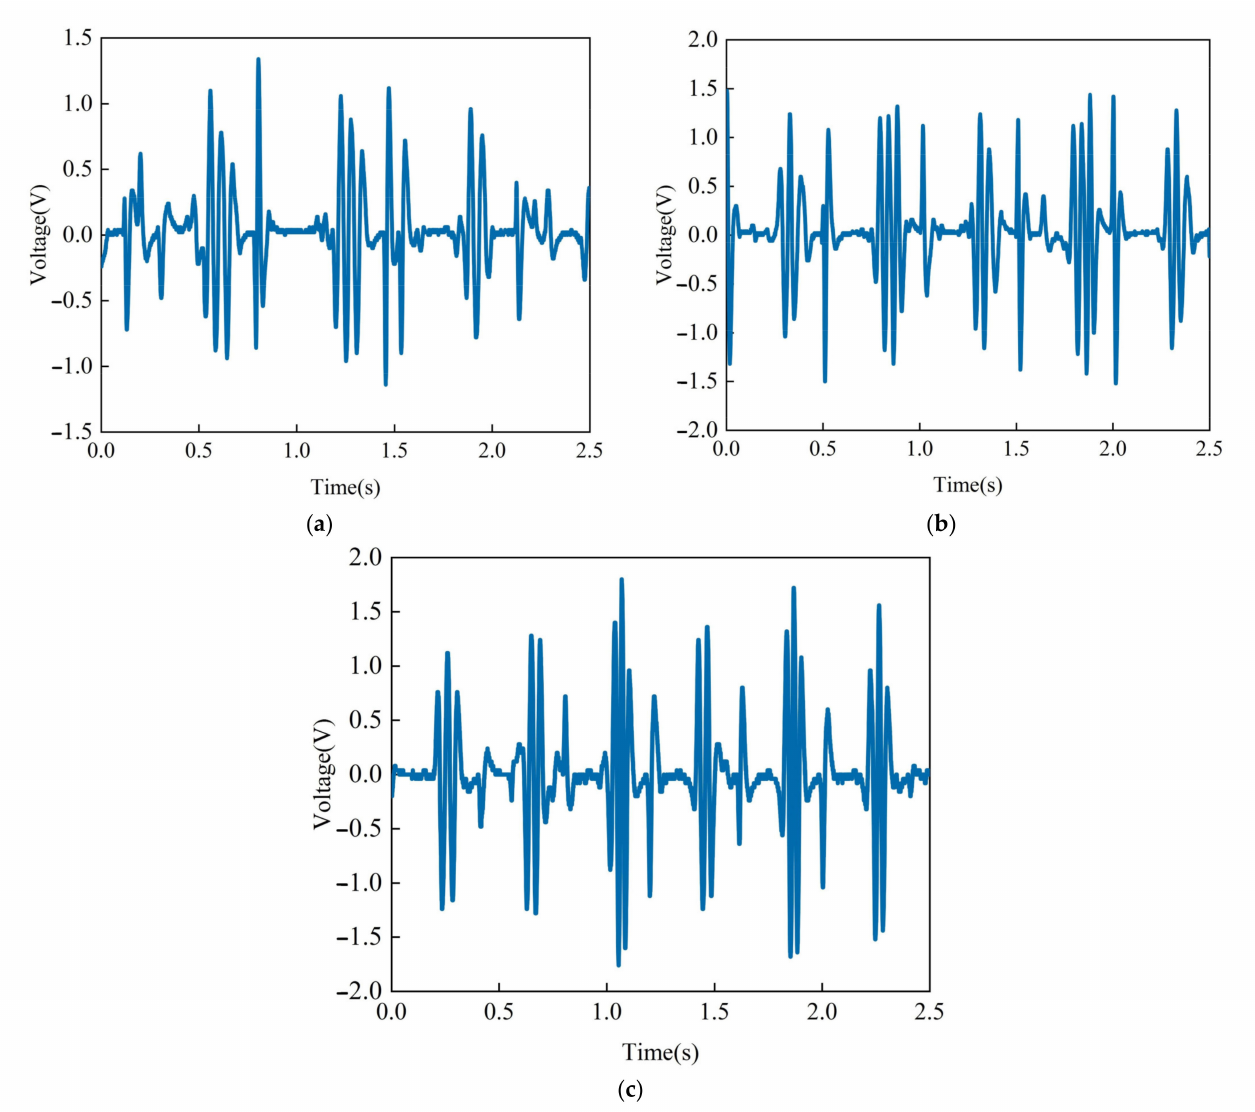
Figure 18. Instantaneous voltage variation curves at 12.5 mm amplitude and different frequency experimental conditions. ( a ) Frequency of 1.5 Hz. ( b ) Frequency of 2 Hz. ( c ) Frequency of 2.5